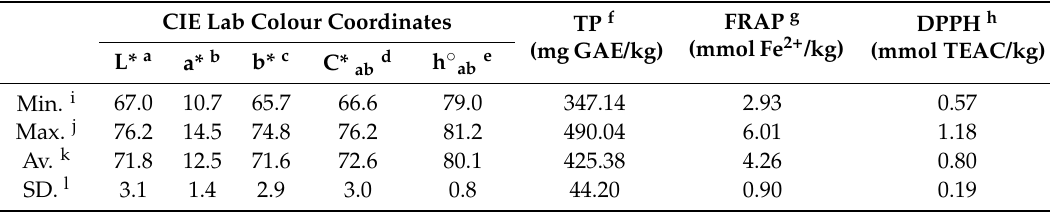
Table 3. The characteristics of S. subspicata Vis. honey samples.